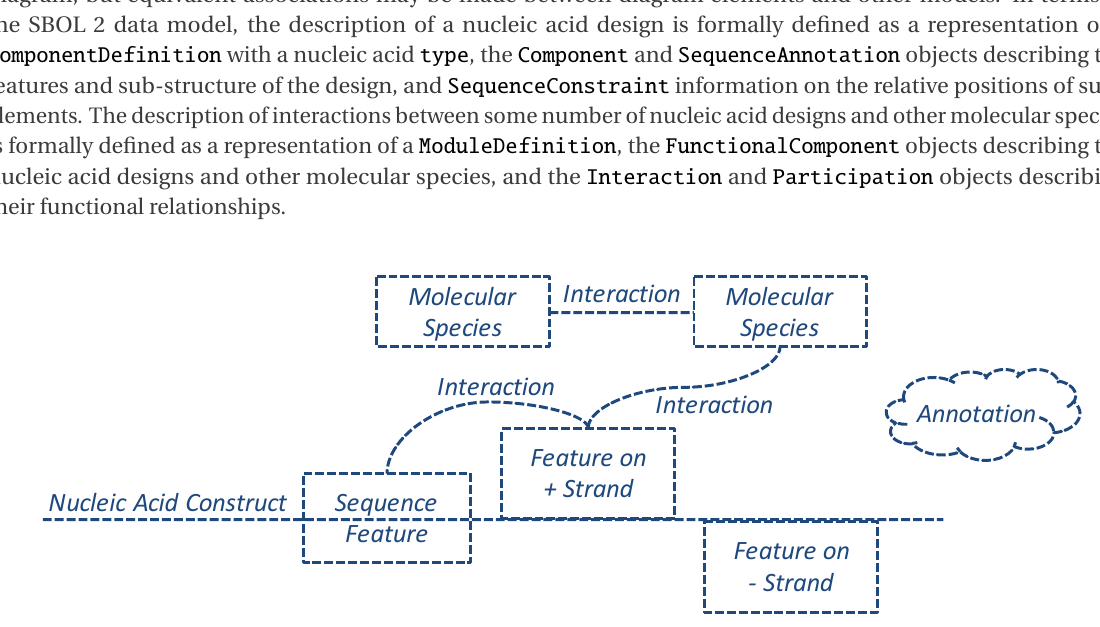
Figure 4: Generic syntax of SBOL Visual 2: a diagram for a nucleic acid construct is based around a backbone line, its structure specified by the sequence of attached sequence feature glyphs. Strand can optionally be indicated by placing a glyph above or below the backbone. Other molecular species are indicated by glyphs not in contact with any backbone. Interactions are directed edges connecting sequence feature or molecular species glyphs. Any of these objects may